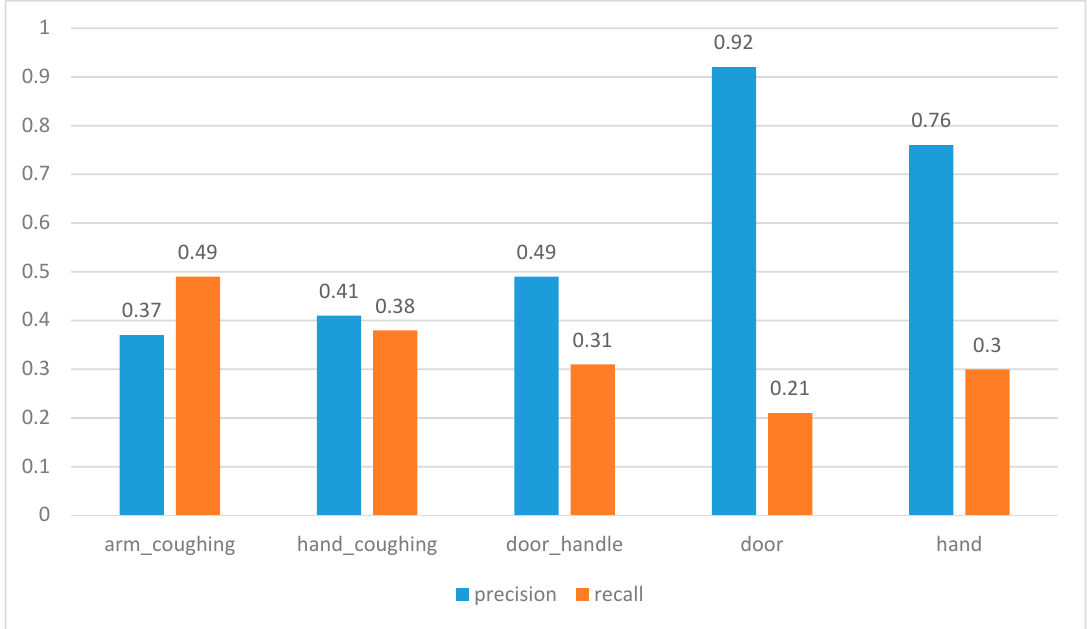
Figure 7. Object detection results of YOu Look at Once (YOLO) architecture.